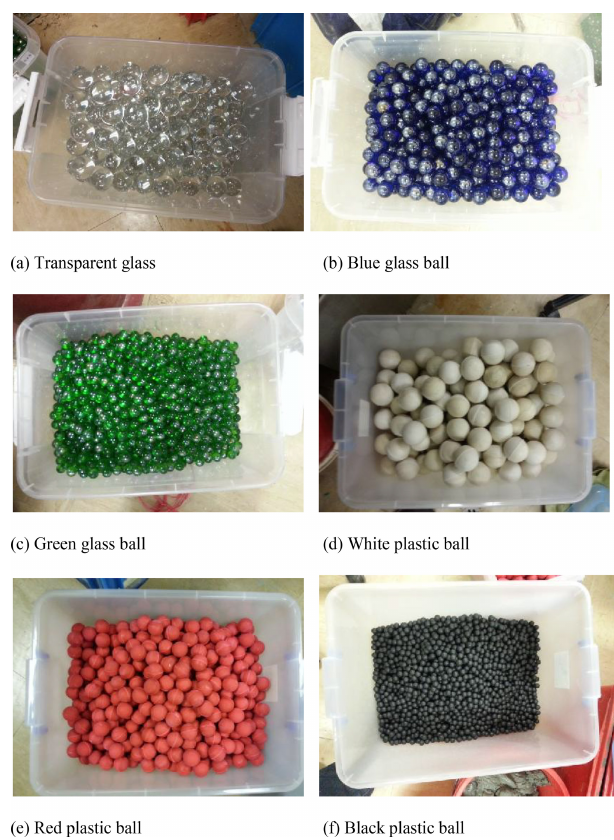
Figure 6. The plastic and glass balls used in the laboratory